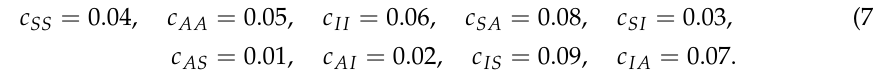
Figure 9. ( Left ): transcritical bifurcations for model (23) obtained with parameter values (72), (55) and initial conditions (50). ( Right ): zoom of the left image showing two bifurcations as r changes; the first one from E 0 to E S when r = r 0 = 2 and the second from E S to E SAI when r = r ‡ = 2.3019. The transcritical bifurcation parameters for both model (1) and (23), still using (55)